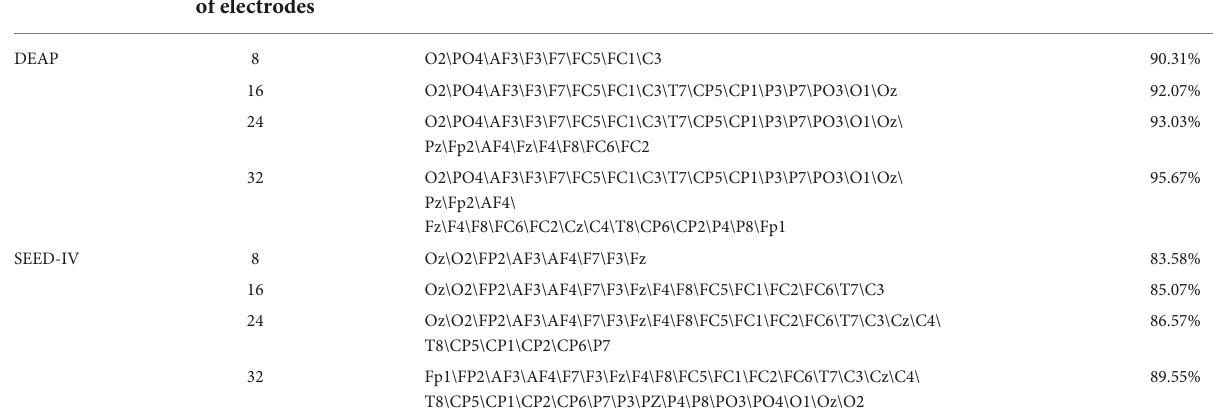
TABLE 7 Evaluation of recognition results based on Fisher.